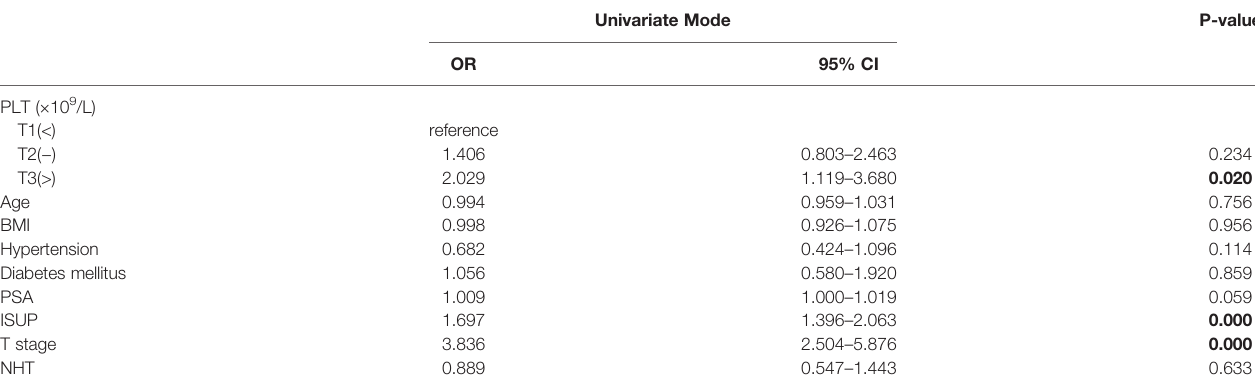
TABLE 3 | Univariate analysis for PCa patients with PNI.